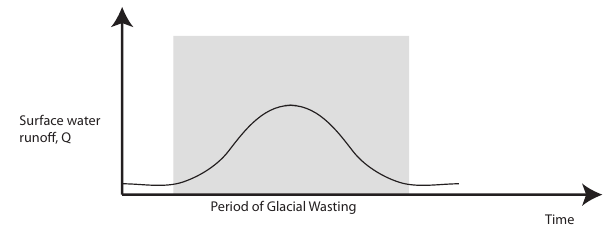
Figure 6. Conceptual graph of surface water runoff as a function of time when glaciers are wasting. Modified from Jansson et al.